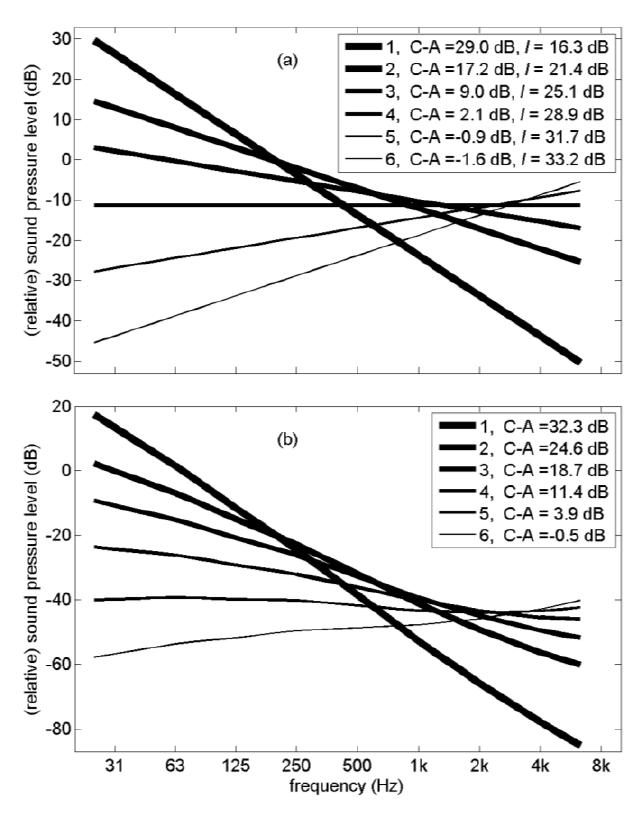
Figure 8. Six linear outdoor 1/3-octave band spectra normalized such that the A-weighted sound level is zero (a) , and corresponding indoor spectra normalized to zero outdoor A-weighted sound level (b) . Values of LF parameter C–A and façade insulation I are indicated in the